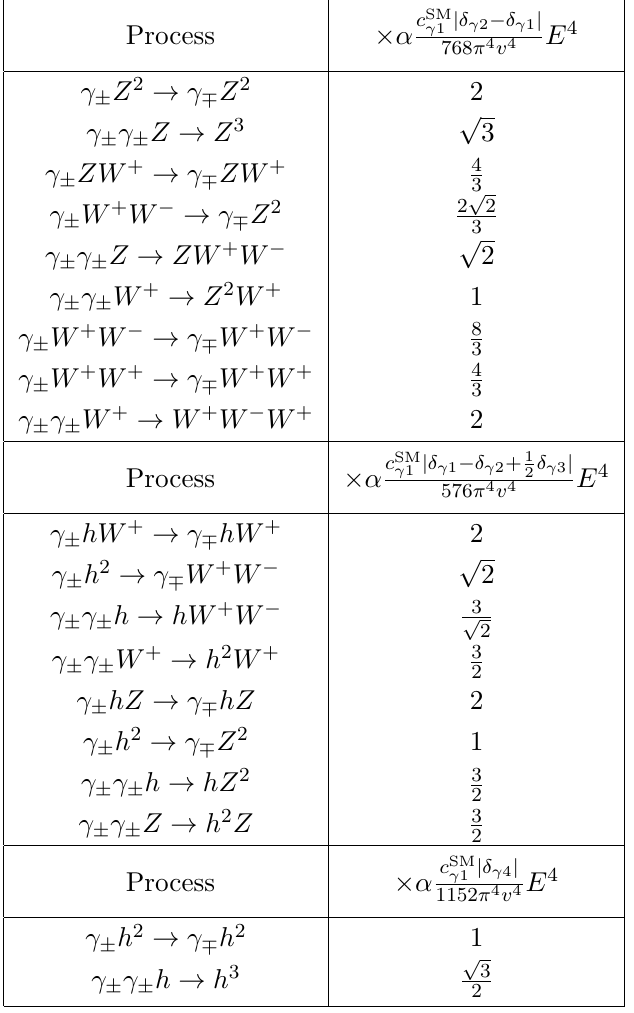
Table 3 . | ˆ M | of the 6-body unitarity-violating processes arising from the modification of the Higgs coupling to γγ .